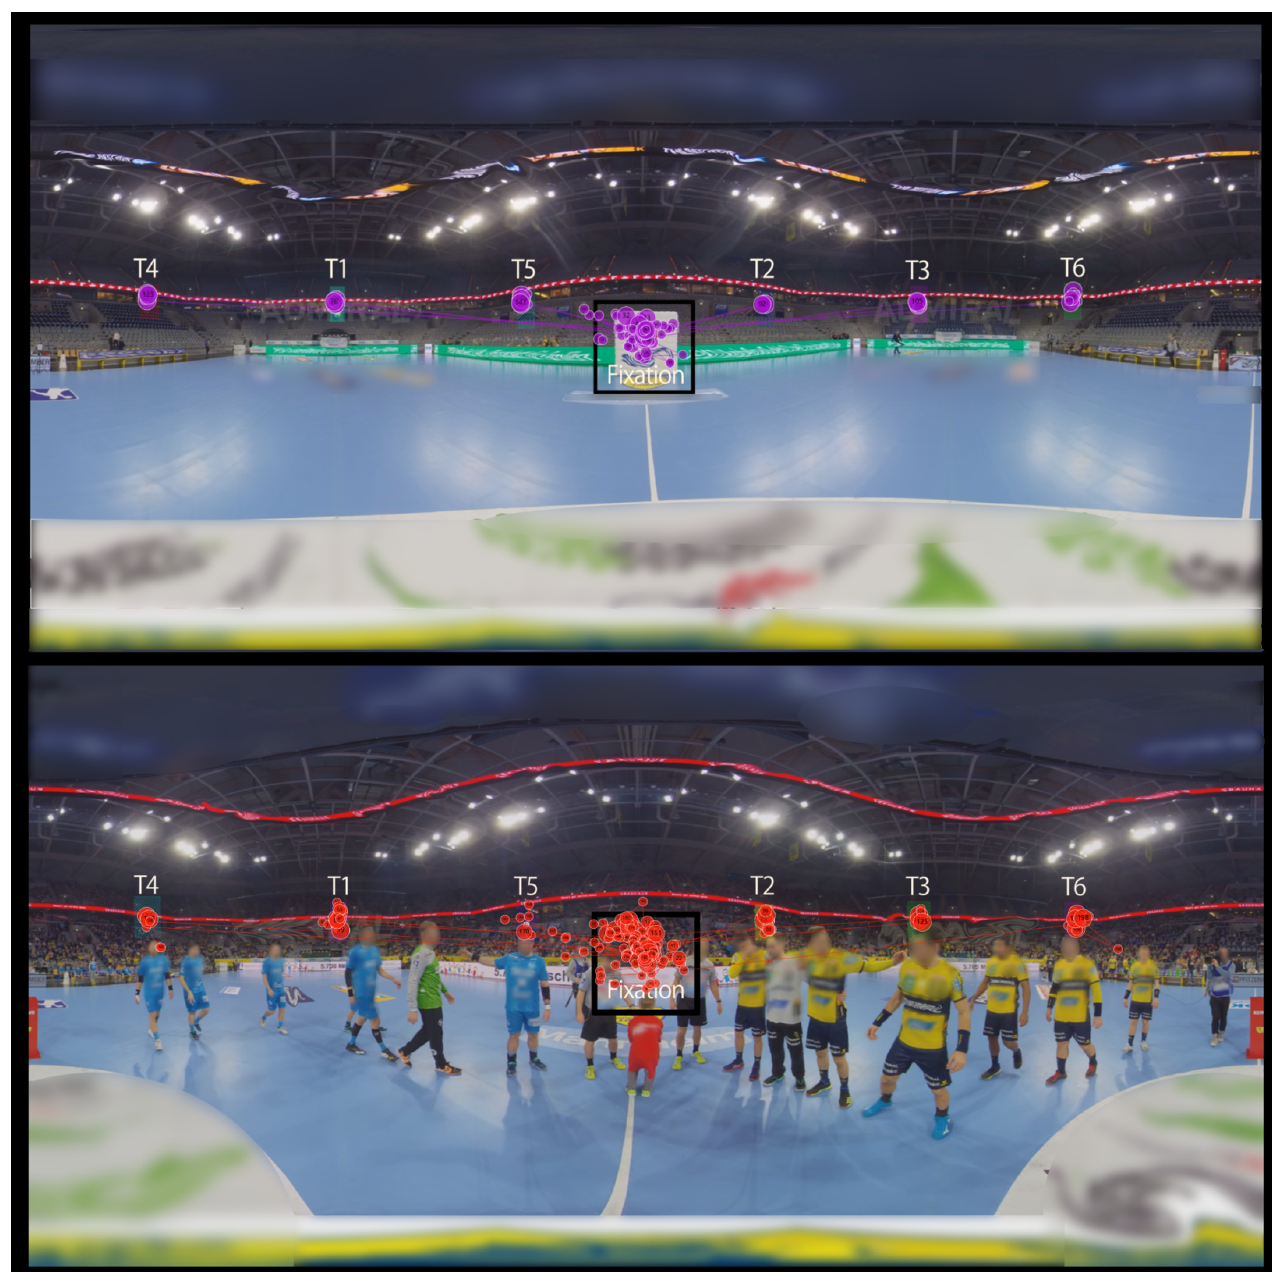
Figure 1. Fixation behaviour from one participant in the empty binaural ( top ) and another participant in the full binaural ( bottom ) conditions overlaid on a snapshot of a trial. Fixations are indicated by purple and red circles. The area where the central fixation cross was presented is indicated by a black square. The six locations are indicated as Tx (T1 to T6), where x is the location’s position in the sequence of six target presentations in a condition. Participant fixations are concentrated over the fixation cross and also in the six target locations. Background is partially scrambled to remove advertisements and faces are blurred to hide identities.